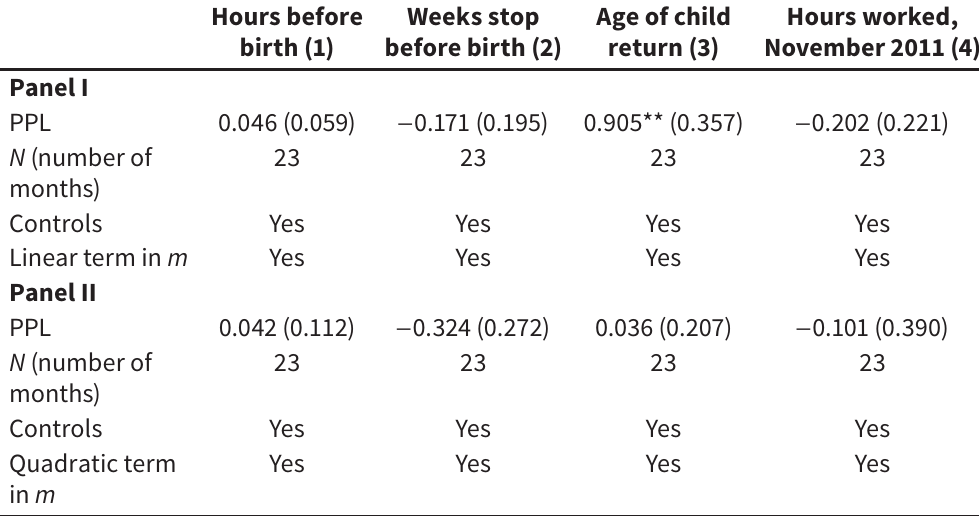
The effect of PPL on maternal labor market